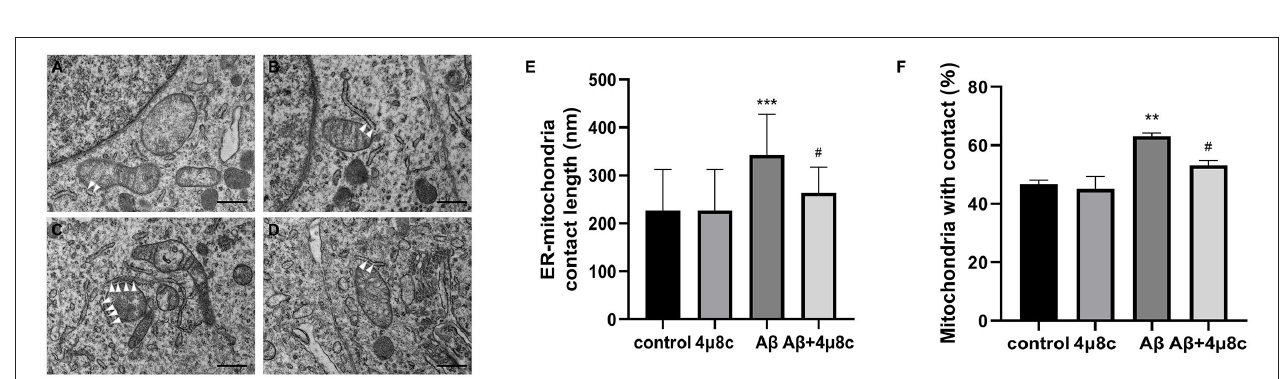
FIGURE 3 | The effect of IRE1 α -XBP1 on mitochondrial function in A β -treated cells. Cells were pretreated with or without 20 µ M 4 µ 8c for 6h, followed by treatment with 20 µ M A β 25–35 for 24h. (A) Cells were lysed on ice with an ATP kit to measure the ATP levels. (B) Mitochondrial membrane potential (MMP) was examined using the fluorescent probe, tetramethylrhodamine (TMRM). (C) Mitochondrial reactive oxygen species (ROS) levels were determined using MitoSoX. Scale bar = 50 µ m. (D) The mean fluorescence intensity of each group was stained by TMRM. (E) Mean fluorescence intensity of each group was stained by MitoSoX. The data are presented as mean ± SD ( n = 3), * P < 0.05 compared with the control. ** P < 0.01 compared with the control. **** P < 0.0001 compared with the control. # P < 0.05 compared with the A β 25–35-alone group. ## P < 0.01 compared with the A β 25–35-alone group.